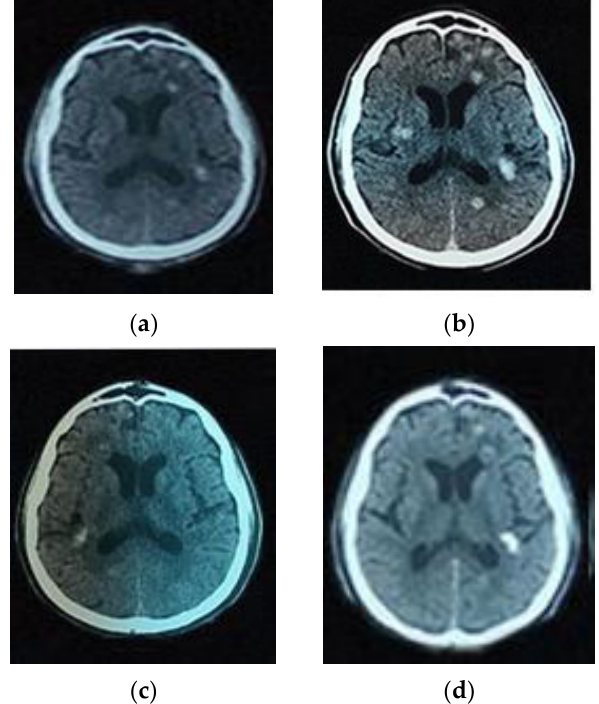
Figure 1. Brain CT scan images of a patient before and after treatment with Albendazole. ( a ) Image of the brain CT scan without contrast product, showing plurifocal nodular lesions reflecting cysticerci of different ages and some of which were calcified before treatment; ( b ) Multifocal nodular image more abundant after injection of the contrast product before treatment; ( c ) Resolution of some lesions with the persistence of calcifications after treatment with a cerebral scanner without contrast product after treatment; ( d ) Image of the brain scanner after injection of the contrast product after treatment.